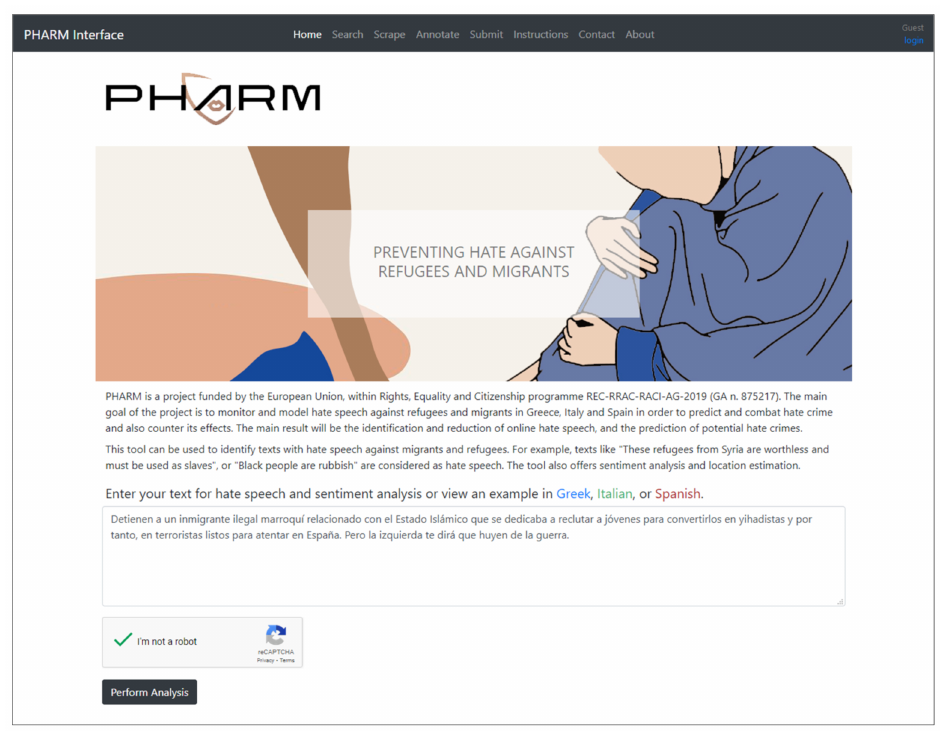
Figure 1. The home screen of the Preventing Hate against Refugees and Migrants (PHARM) web interface.